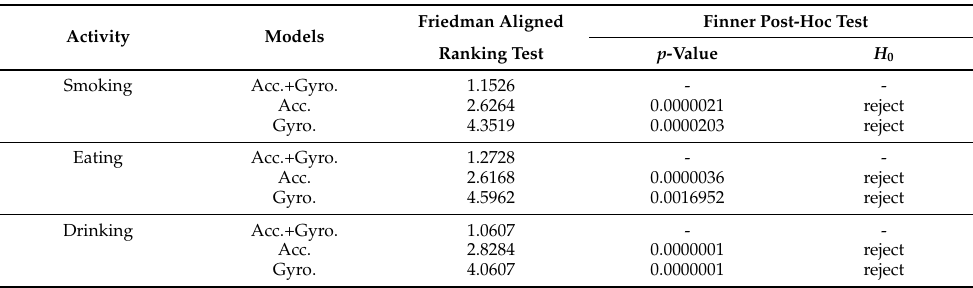
Table 10. Friedman aligned ranking test and Finner post-hoc test based on the accuracy metrics of the 1D-ResNet-SE model using different sensor data on the UT-Smoke dataset.